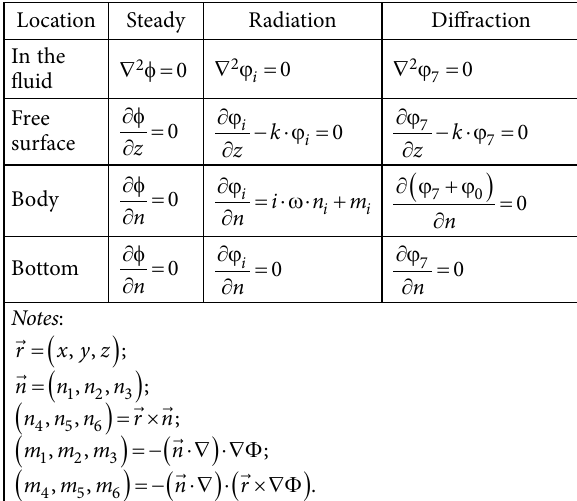
Location Steady Radiation Diffraction In the fluid Free surface Bottom 0 Notes